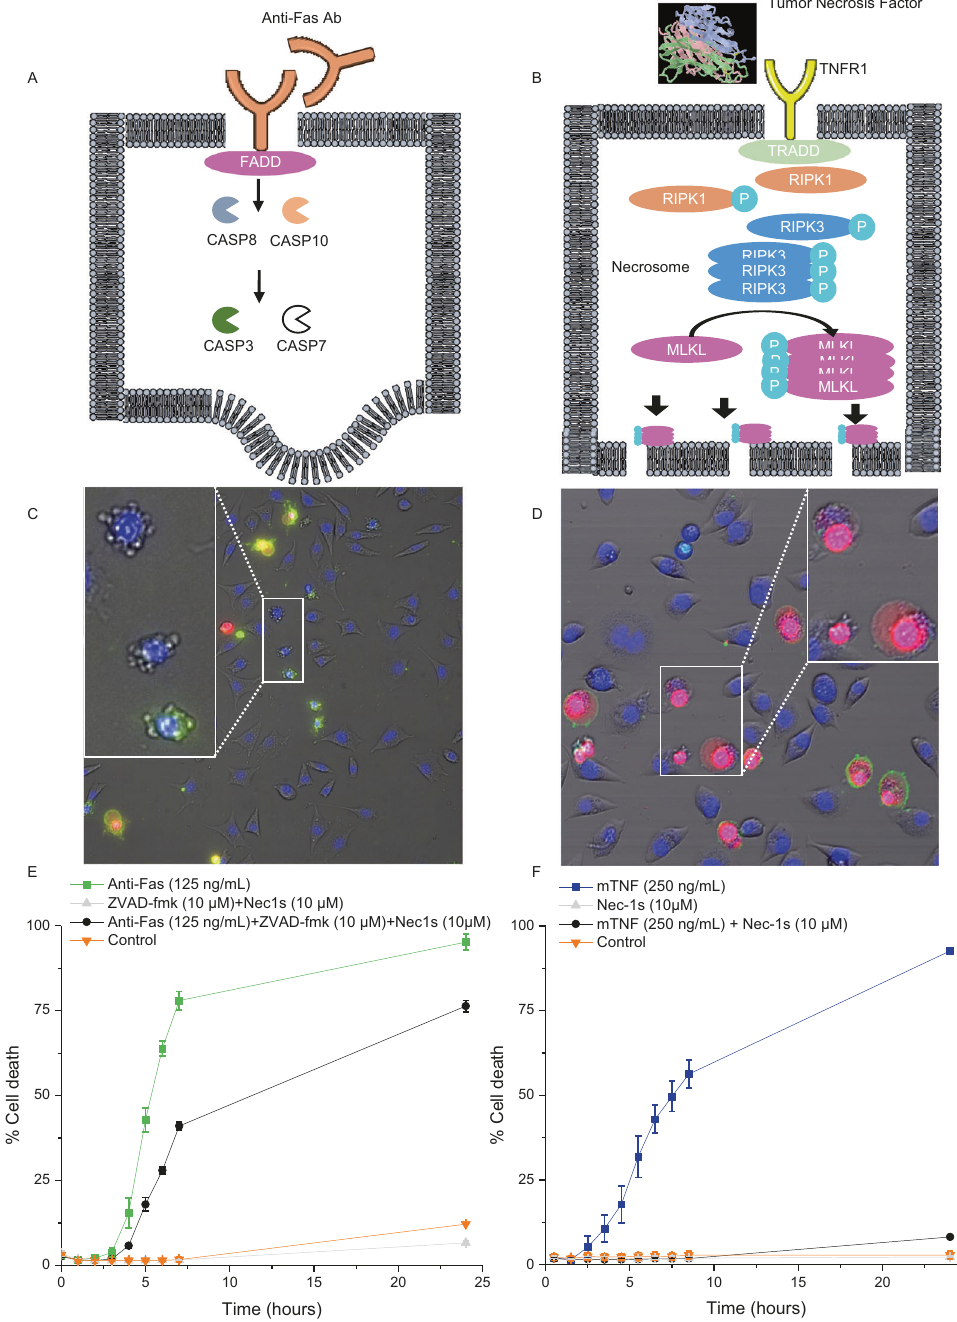
cells), containing cells of independent experiments, was used to predict and validate the accuracy of the model itself (Fig. 4B, C). Resulting in 88%, 82 and 91% accuracy on the holdout set for alive, apoptotic and necroptotic cells respectively (Fig. 4C). The accuracy is calculated by the number of cells predicted to the correct category divided by the total number of cells in the associated experiments (Fig. 4C). The receiver operating char- acteristic (ROC curve), is a plot showing the true positive rate compared to the false negative rate (Fig. 5). The area under each curve, gives an indication of the overall performance of each classi fi er with a higher area under each curve being a better classi fi er. The diagonal dashed line in the middle gives the